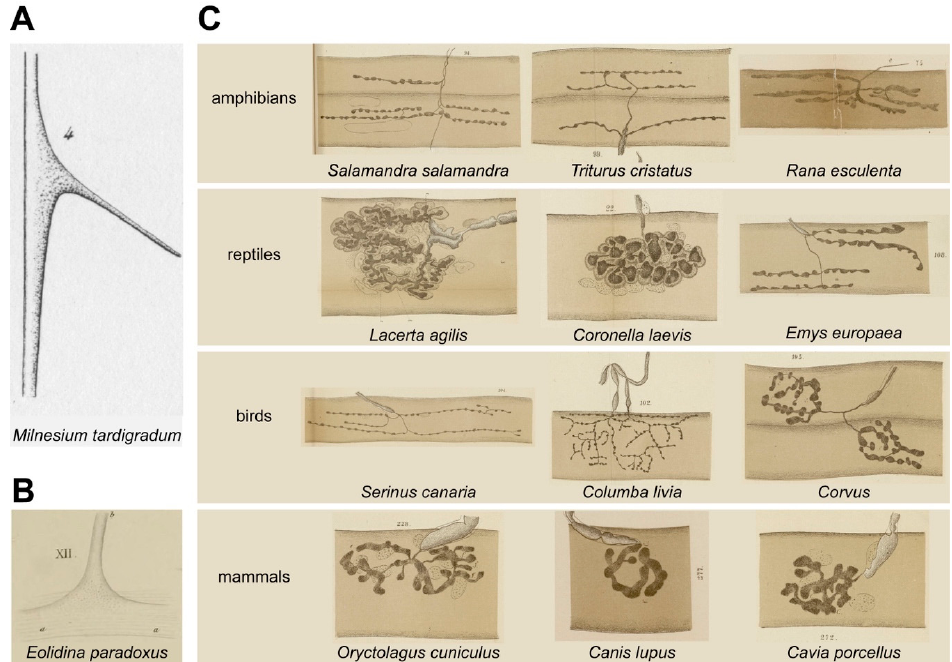
Figure 1. Historical anatomic drawings of NMJs. A-B: Presumably the first drawings of NMJs from the early 1840ies. Figures show reprints of NMJs from the tardigrade, Milnesium tardigradum ( A ) and the snail, Eolidina paradoxus ( B ). Reproduced from [4,5], original sources: www.biodiversitylibrary.org / item / 47974# page / 7 / mode / 1up and www.biodiversitylibrary.org / item / 47973#page / 9 / mode / 1up. ( C ). Selection from the more than 300 NMJs depicted by Willy Kühne in 1886 shows the variety of vertebrate NMJ morphologies. Reproduced from [6], original source: https: // catalog.lib.uchicago.edu / vufind / Record /